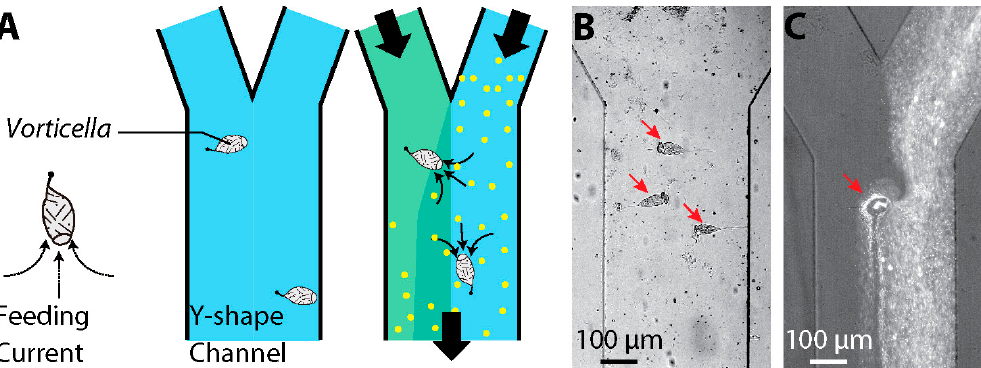
Figure 6. Vorticella as a microfluidic mixer (reproduced from [101]). ( A ) Schematic of using the Vorticella cilia for micromixing; ( B ) V. convallaria cells in a Y-channel; ( C ) transport of microparticles by a single V. convallaria cell, and resultant mixing between two streams in the Y-channel.